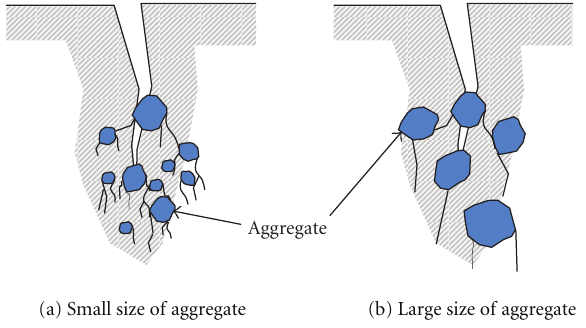
Figure 2: E ff ect of size of coarse aggregate on microcracking.